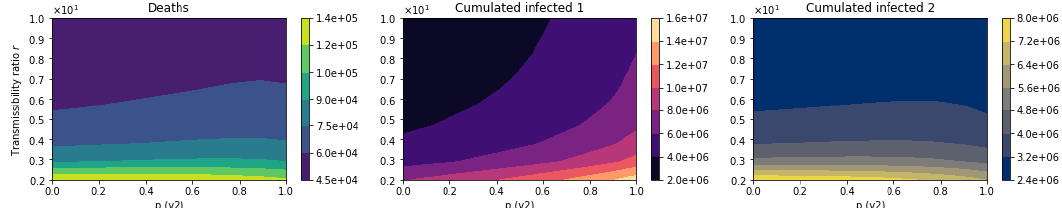
Figure 9. Total number of deaths and the cumulative number of infected people for each age group. This scenario considers a relatively low SARS-CoV-2 transmission rate. The factors that is varied is the transmission rate of 55+ age group.